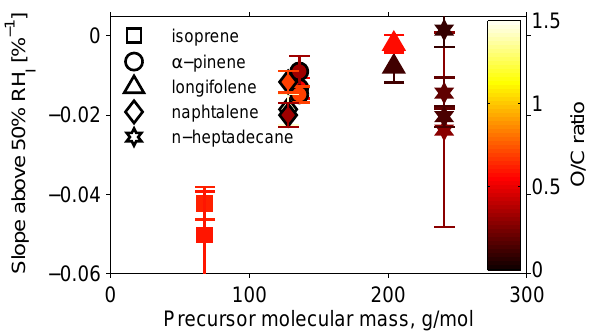
Fig. 9. The slope of the bounce at RH I > 50% versus precursor molar mass for the studied systems. Error bars mark the standard error of the slope of each